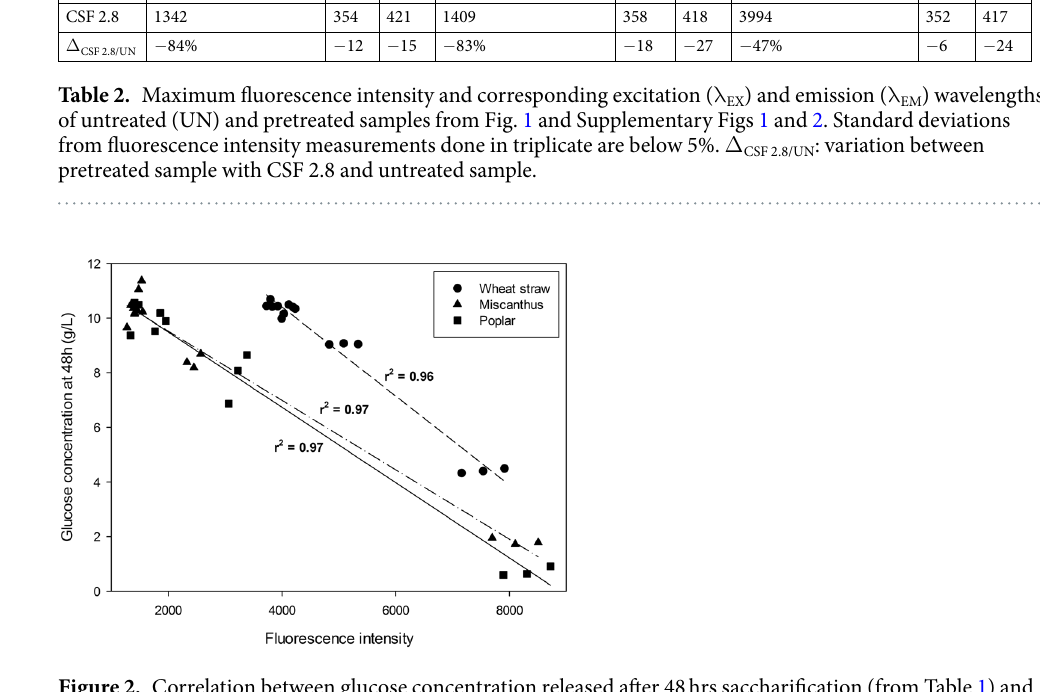
Figure 2. Correlation between glucose concentration released after 48 hrs saccharification (from Table 1) and maximum fluorescence intensity (from Table 2) of untreated and pretreated samples. Correlation coefficient and related correlation line are drawn for each biomass sample (wheat straw: short dash line; miscanthus: dash and dot line; poplar: solid